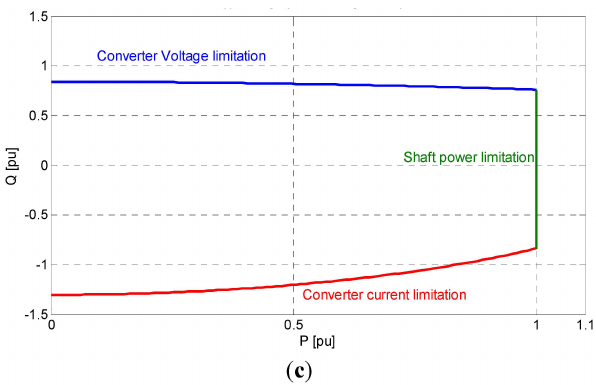
Figure 3. Capability curves of an inverter-based RES-DG for design pf = 0.95 and different grid voltages. ( a ) Vg = 0.95 p.u.; ( b ) Vg =1.0 p.u.; and ( c ) Vg = 1.05